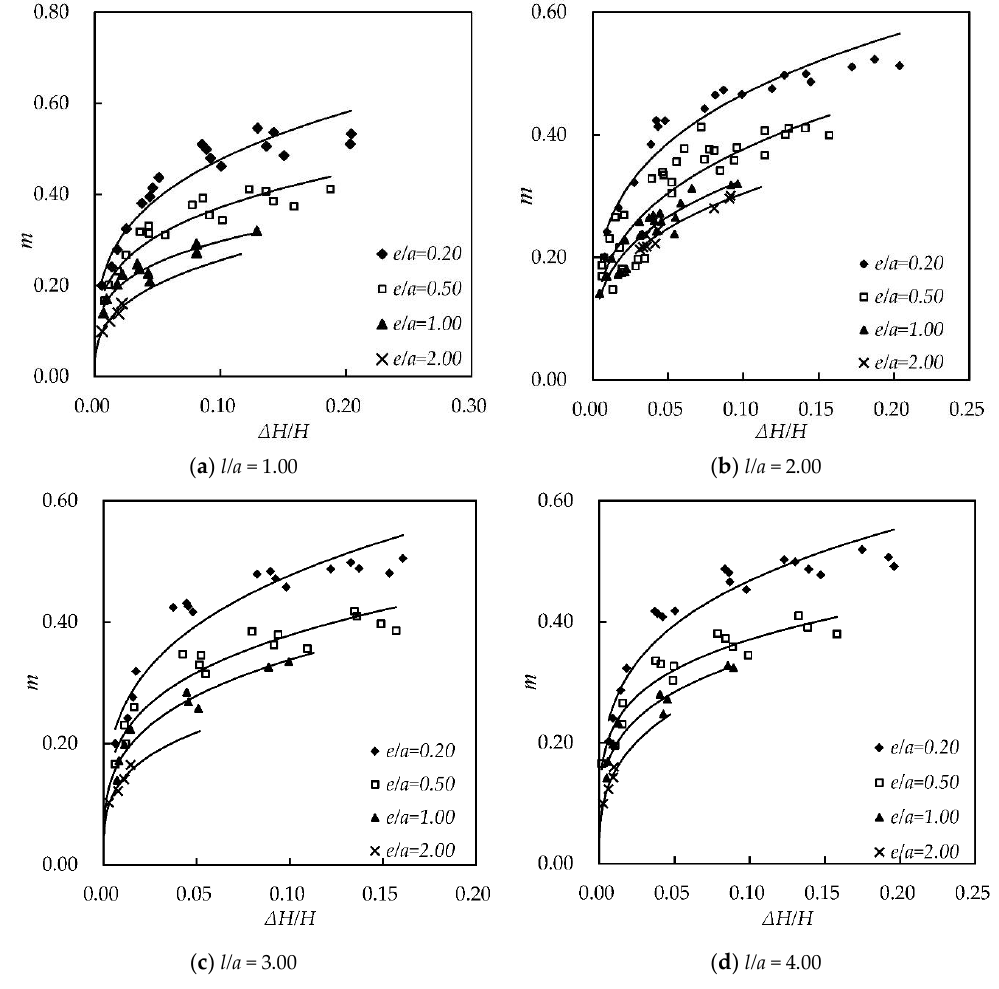
Figure 7. m as a function of Δ H/H for different l/a values.